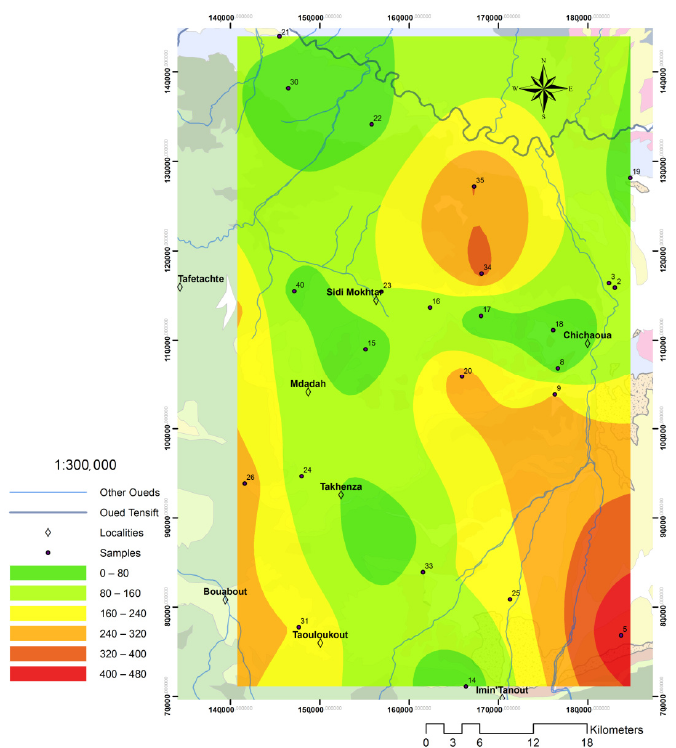
Figure 13. Spatial distribution of the Nitrates in the study area.